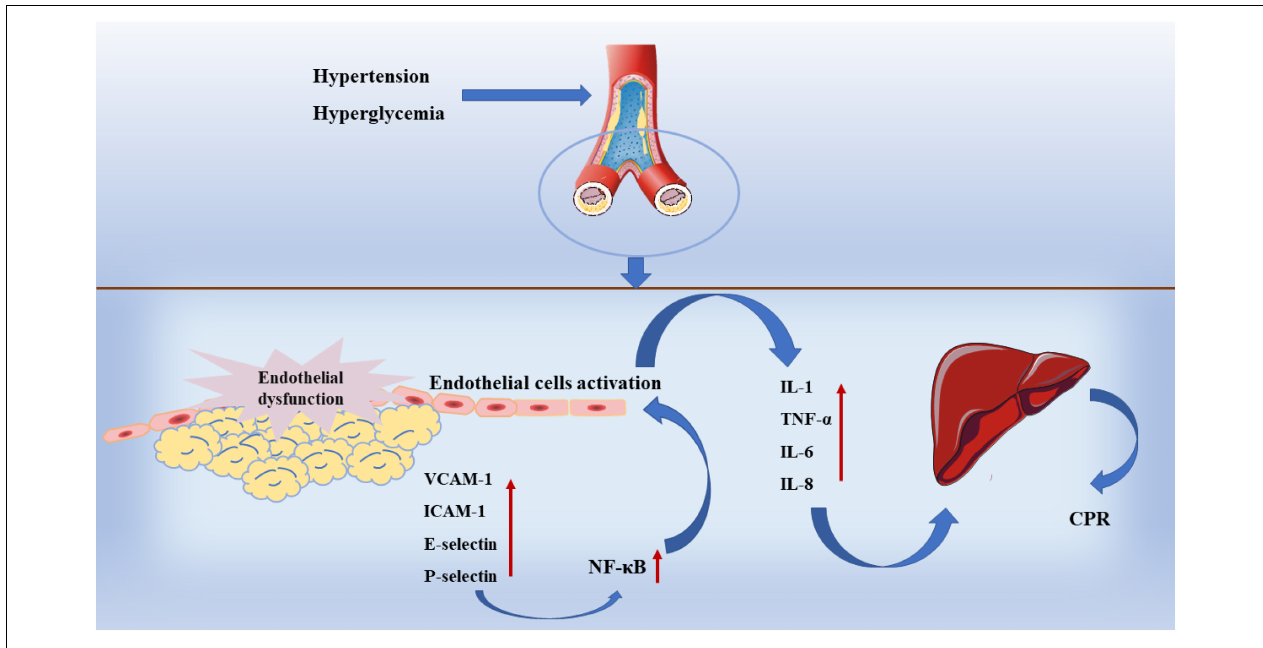
FIGURE 4 | Inflammation in